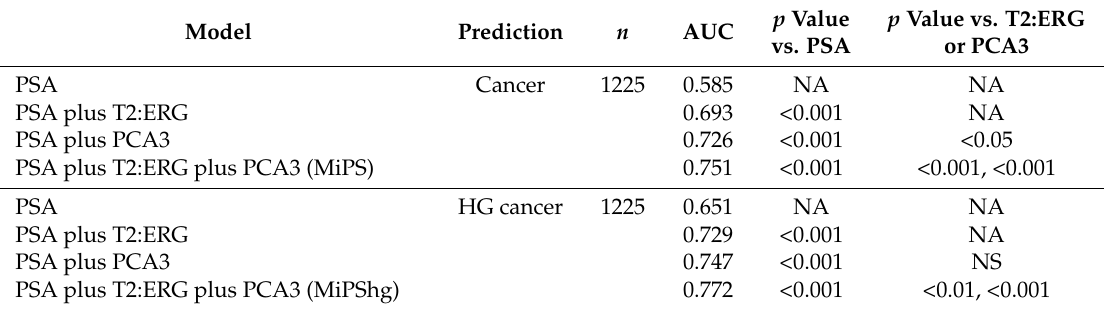
Table 2. Performance of serum prostate-specific antigen-based models for predicting cancer and high-grade cancer on biopsy (Adapted from